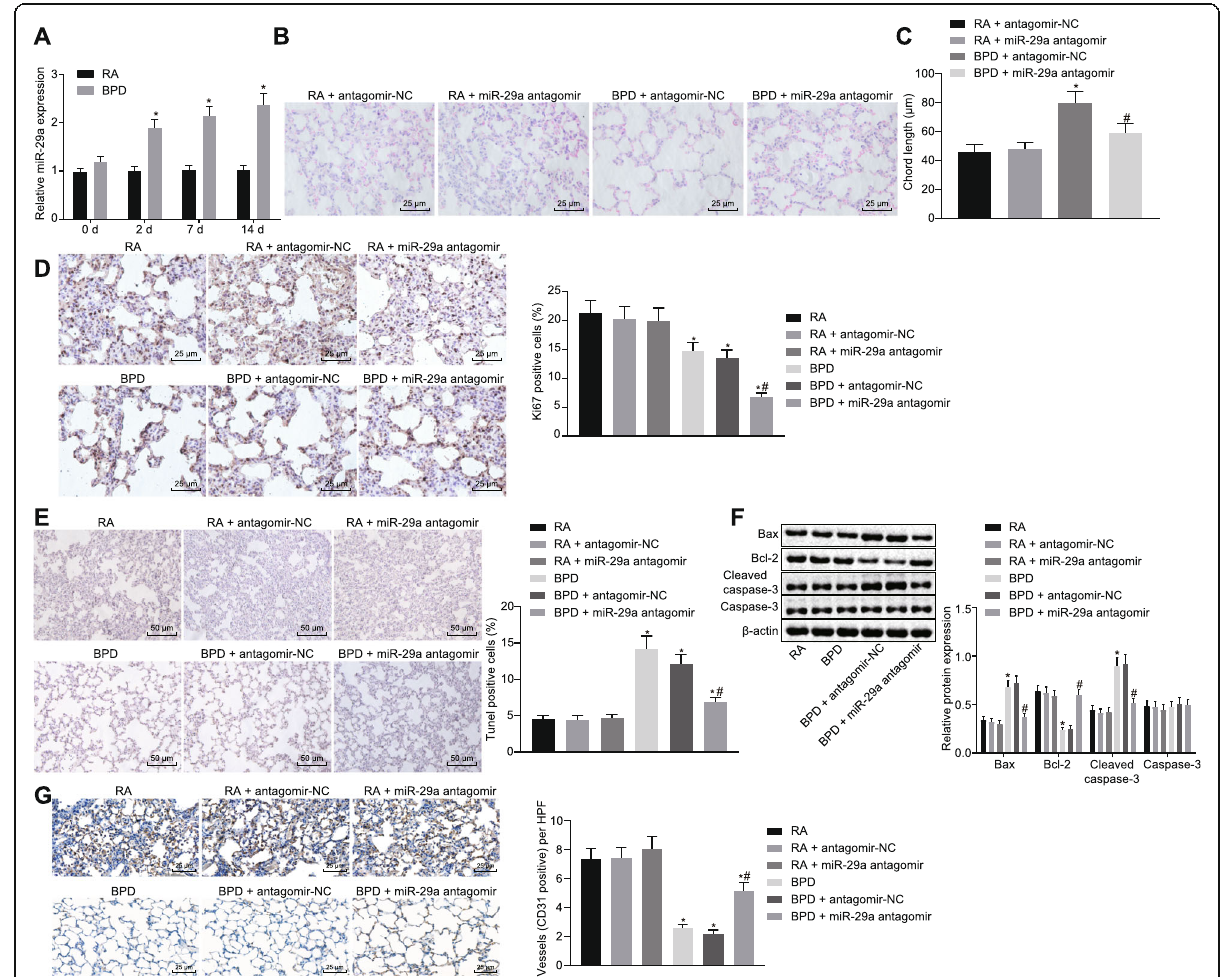
Fig. 2 Inhibition of miR-29a impedes hyperoxia-induced BPD in neonatal mice. A, The expression of miR-29a in lung tissues of neonatal mice under exposure of RA or hyperoxia determined by RT-qPCR. * p < 0.05 vs. neonatal mice under exposure of RA (the RA group). B, HE staining analysis of lung tissues in each group (× 400). C, Alveolar chord length of lung tissues in each group. D, Positive expression rate of Ki67 protein in lung tissues of each group determined by immunohistochemistry (× 400). E, Cell apoptosis in lung tissues of each group assessed by TUNEL staining (× 200). F, Western blot analysis of apoptosis-related proteins (Bax, Caspase-3 and Bcl-2) in lung tissues of each group. G, Positive expression rate of CD31 protein in lung tissues of each group determined by immunohistochemistry (× 400). In panel C-F, * p < 0.05 vs. neonatal mice under exposure of RA (the RA group). # p < 0.05 vs. neonatal mice with hyperoxia-induced BPD receiving antagomir-NC (the BPD + antagomir-NC group). N = 15. Measurement data were expressed as mean ± standard error. Data comparison between two groups was examined by unpaired t -test. miR-29a, microRNA-29a; BPD, bronchopulmonary dysplasia; RA, room air; Bax, Bcl-2-associated X protein; Bcl-2, B-cell